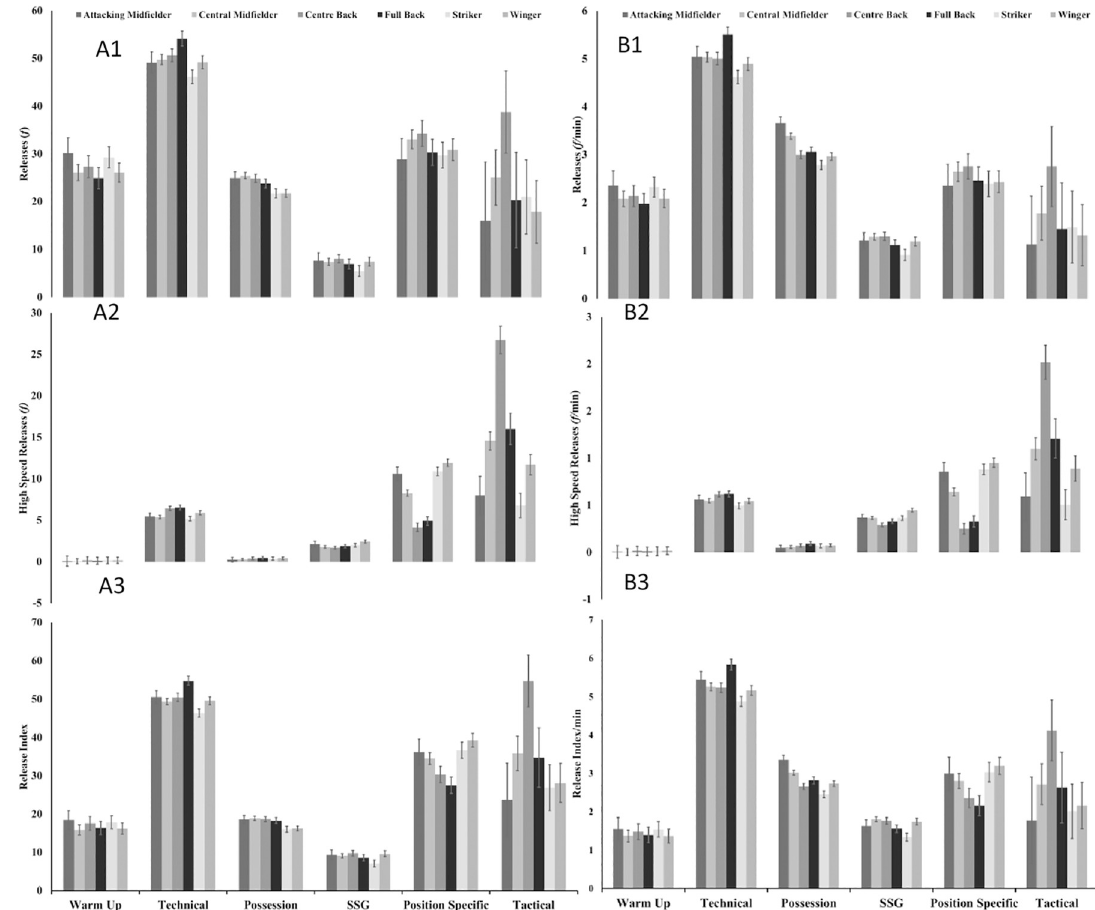
Fig 2. Absolute (a) and relative (b) estimated marginal means for number of ball releases (1), number of high-speed ball releases (2) and ball release index (3) during different training drills categories (warm-up, technical, possession, small-sided game [SSG], playing position specific and tactical) according to playing